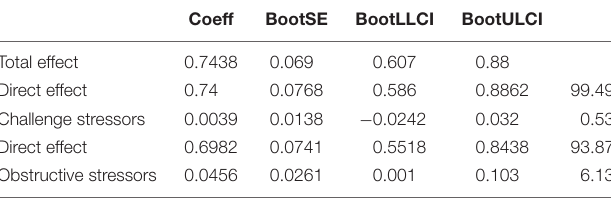
TABLE 3 | Mediating effect of the use of enterprise social media for work tasks.